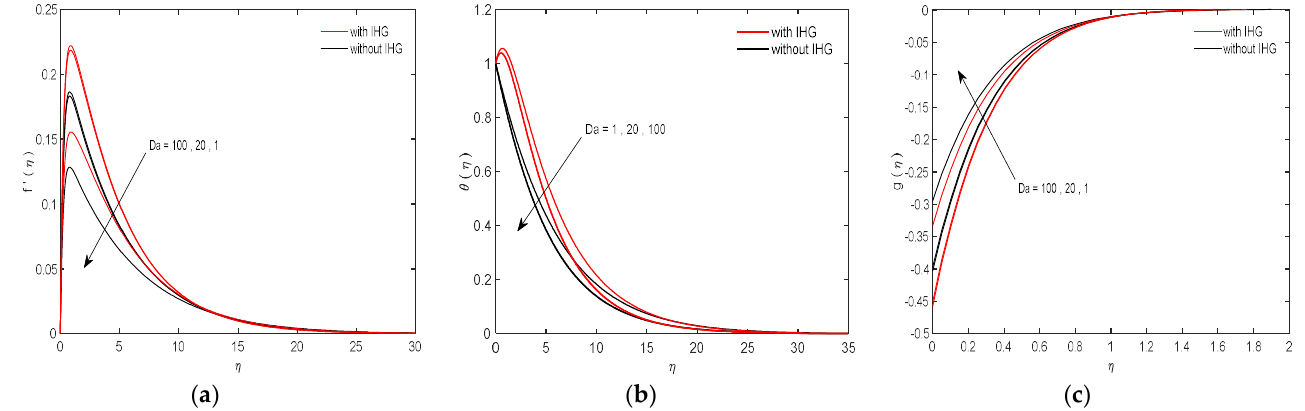
Figure 5. The effect of the Darcy number Da on the ( a ) velocity profile, ( b ) temperature profile and ( c ) angular velocity profile for R = 0.5, M = 2, λ = 0.5, c = 1, B = 0.2, φ 1 = φ 2 = 0.05, Rd = 1, n = 0.5, f w = 0.5.